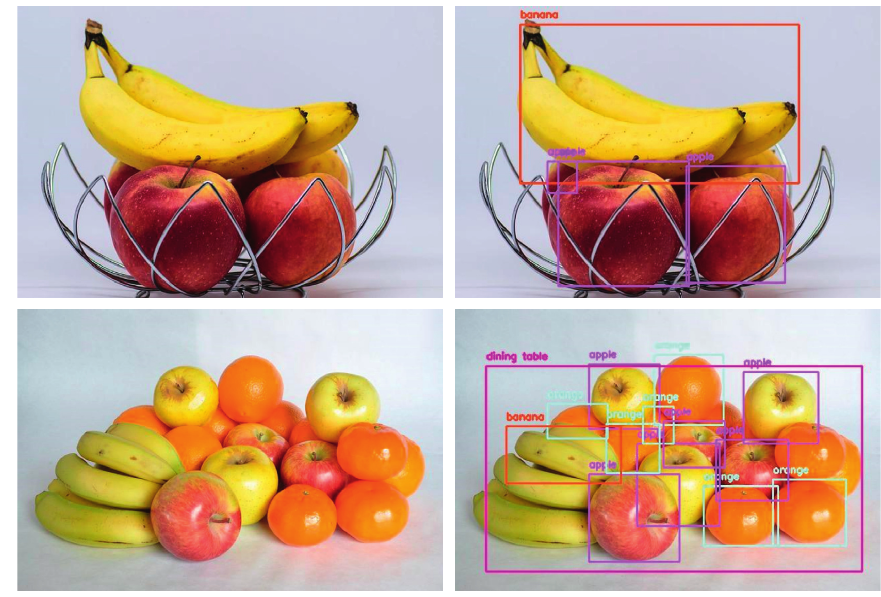
Figure 17: Result for image